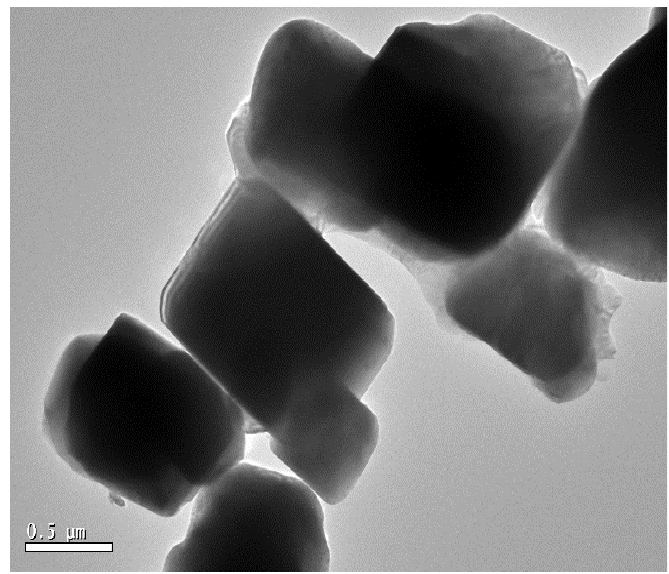
Figure 4. Transmission electron microscopic image of gahnite ferroan composite.